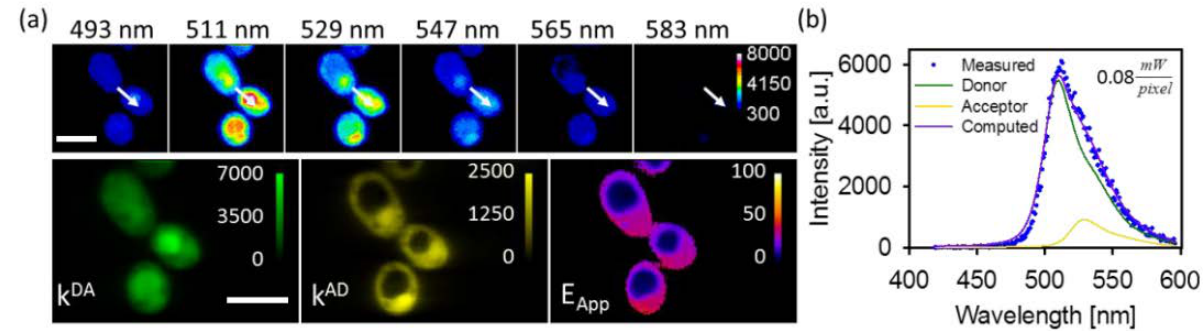
Figure 3. Typical results obtained from yeast cells expressing a FRET construct (DDDA) as measured with the line-scan optical micro-spectroscopy systems. Images in the top row of panel ( a ) illustrate the fluorescence emission images of the cells acquired at different wavelengths selected from a total of 200 wavelengths over the 420–600 nm range. These were unmixed into donor emission in the presence of acceptor ( k DA ) and acceptor emission in the presence of donor ( k AD ), from which the apparent FRET efficiency distribution ( E was computed for each image pixel (see the Methods section); and ( b ) Fluorescence spectra corresponding to the pixel indicated by the white arrows in ( a ). Measured fluorescence spectra are represented by filled circles, unmixed donor spectrum by green solid line, unmixed acceptor spectrum by yellow solid line, and the best-fit simulated spectrum by purple solid line. Scale bars, 5